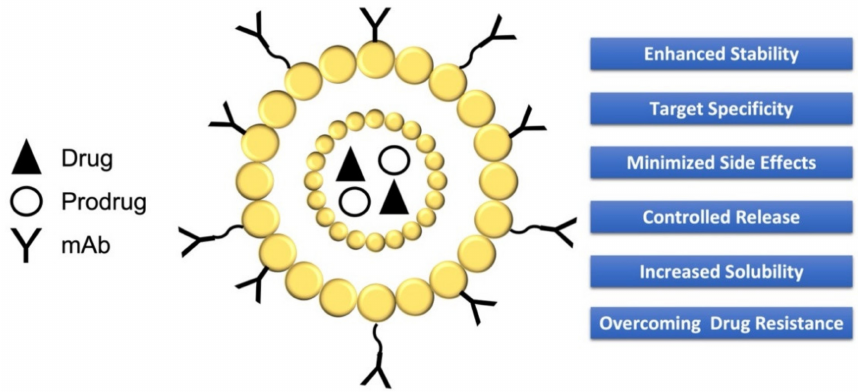
Figure 1. NP entrapping drugs and prodrugs coated with mAbs. List of advantages in the use of